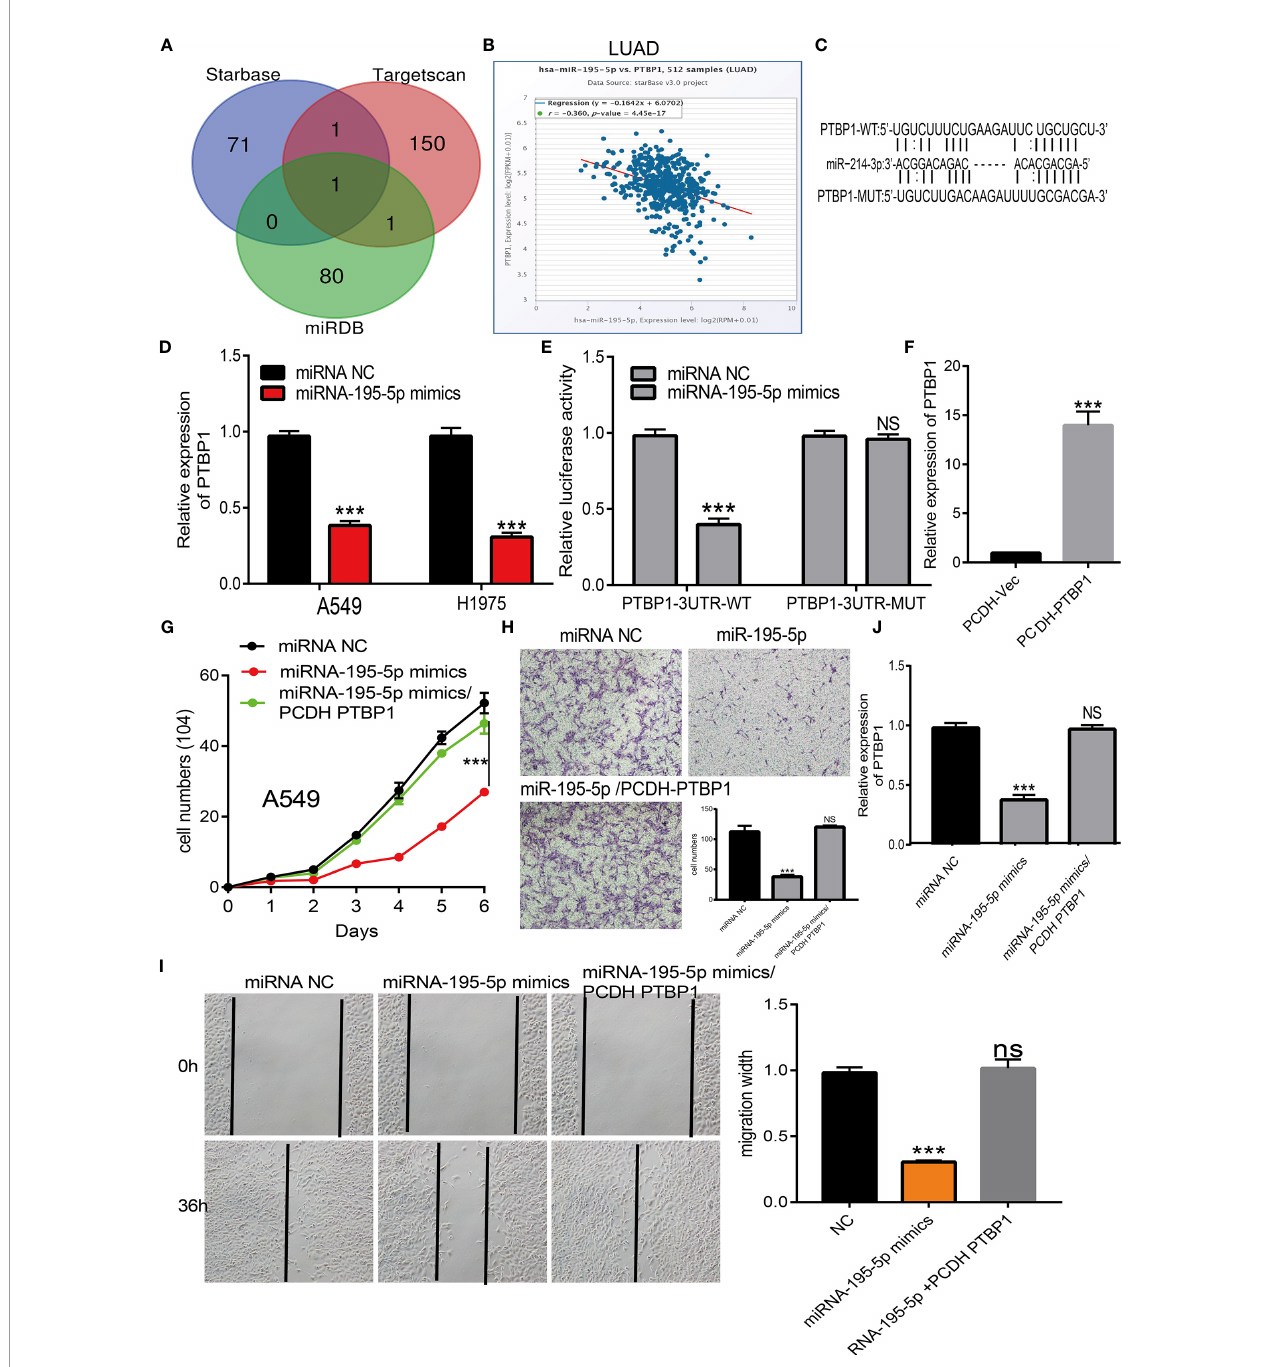
FIGURE 6 | MiR-195-5p modulates the proliferation and migration of LUAD by Targeting PTBP1. (A) Identity the PTBP1 as the target gene of miRNA-195-5p by employed diverse public databases. (B) The correlation between the miRNA-195-5p and PTBP1 in TCGA LAUD data. (C) The target sites between the miRNA-195- 5p and PTBP1 were predicted by starBase. (D) The expression of PTBP1 in LUAD cell after over-expression of miRNA-195-5p was examined by the qRT-PCR assay. (E) The luciferase activities of the PTBP1 luciferase reporter vector (WT or MUT) in A549 cells transfected with miRNA-195-5p mimics or mimics NC. (F) The over-expression ef fi cient of PTBP1 in A549 cells examine by qRT-PCR assay. (G) Overexpression of PTBP1 could reverse the repressed cell proliferation induced by miR-195-5p overexpression in A549 cells examined by growth curve assay. (H) Overexpression of PTBP1 could reverse the repressed cell migration induced by miR-195-5p overexpression in A549 cells examined by transwell assay. (I) The expression of PTBP1 in A549 cells after transfection miR-195-5p mimics and over- expression of PTBP1. Quanti fi cation data were also indicated. (J) Overexpression of PTBP1 could reverse the repressed cell migration induced by miR-195-5p overexpression in A549 cells examined by wound healing assay. Scale bar=50 m m. ***P<0.001; NS, p >